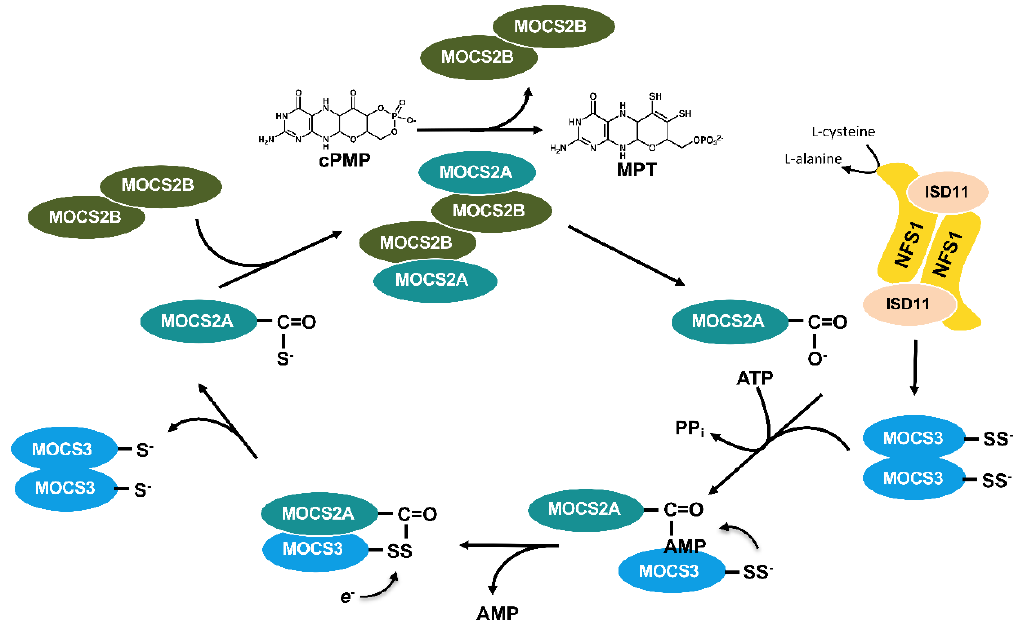
Figure 10. Regeneration of the thiocarboxylate group on MOCS2A. Conversion of cPMP to MPT requires the transfer of two sulfur, a reaction catalyzed by MPT synthase. The formation of the MOCS2A thiocarboxylate group is catalyzed after the formation of the (MOCS2A / MOCS3) 2 complex in humans. First, MOCS2A-AMP is formed under ATP consumption. MOCS3 receives the sulfur from NFS1, and a persulfide group is formed at the C-terminal domain of MOCS3. This sulfur is then transferred to MOCS2A with the formation of a perthiocarboxylate group as the intermediate. After reductive cleavage, the thiocarboxylate group on MOCS2A is formed and MOCS2A-SH reassociates with MOCS2B.